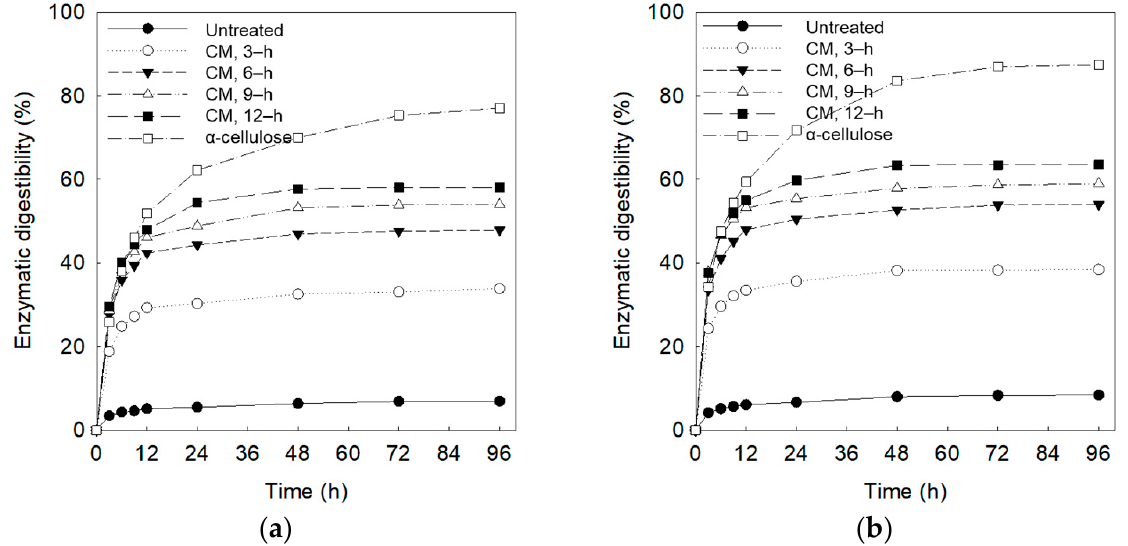
Figure 1. Enzymatic digestibility of untreated and CM-treated oak wood with ( a ) 15 FPU/g glucan and ( b ) 30 FPU/g glucan.